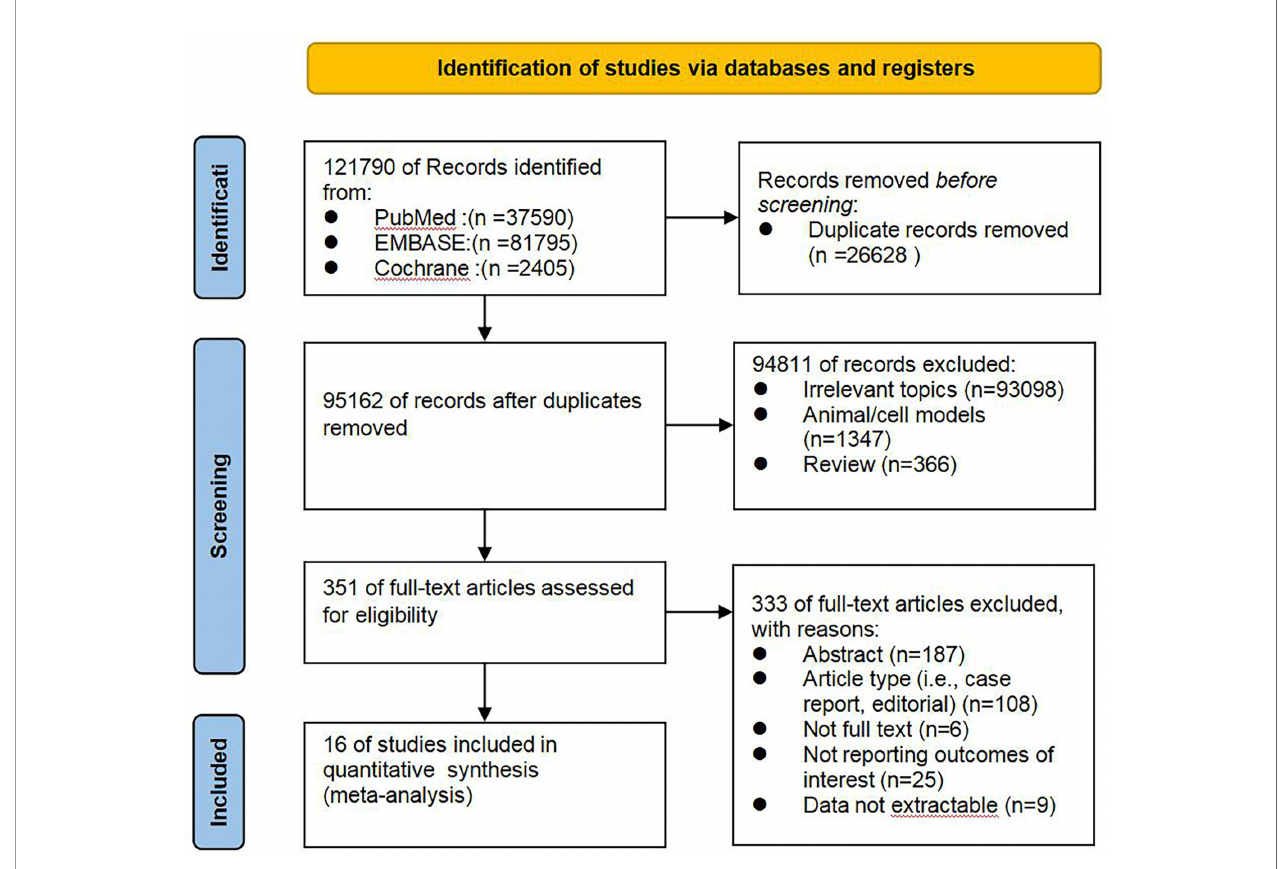
FIGURE 1 | Flow diagram of studies identi fi cation and